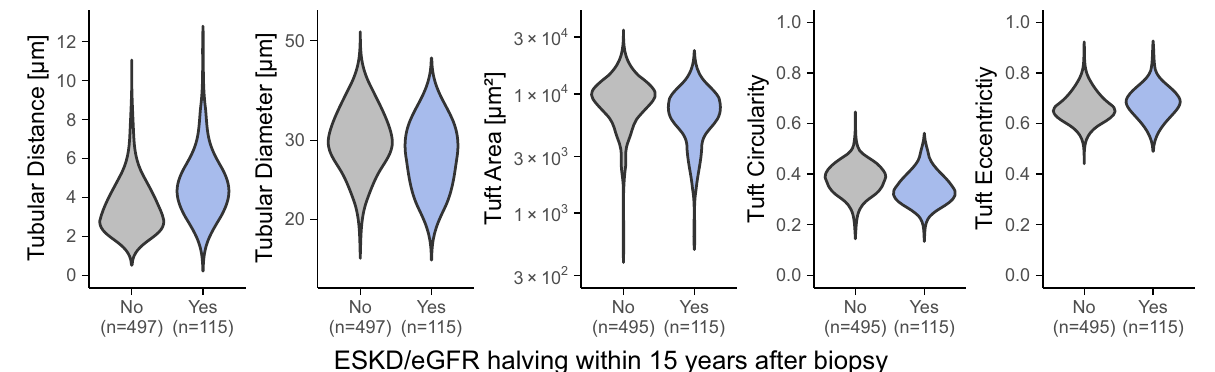
Fig.4|NGM-derivedquantitativefeaturesarepredictiveofdiseaseprogression in IgA nephropathy (IgAN). a Comparison of fi ve predictive digital biomarkers summarised at patient-level based on reaching the de fi ned composite endpoint, i.e., end-stage kidney disease and/or halving of initial estimated glomerular fi ltra- tionrate(eGFR)within15yearsafterbiopsy. b UnivariateCoxproportionalhazards models for 644 patients of the fi ve predictive features summarised at patient-level including 95% con fi dence intervals. In three cases no glomerular tuft was